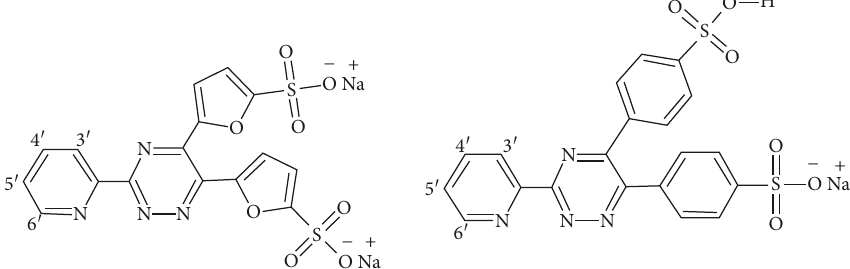
Figure 1: Chemical structures of 3-(2-pyridyl)-5,6-di(2-furyl)-1,2,4-triazine-5 ′ ,5 ″ -disulfonic acid disodium salt (ferene: L1) (left) and 3-(2-pyridyl)-5,6-diphenyl-1,2,4-triazine-4 ′ ,4 ″ -disulfonic acid sodium salt (ferrozine: L2) (right).